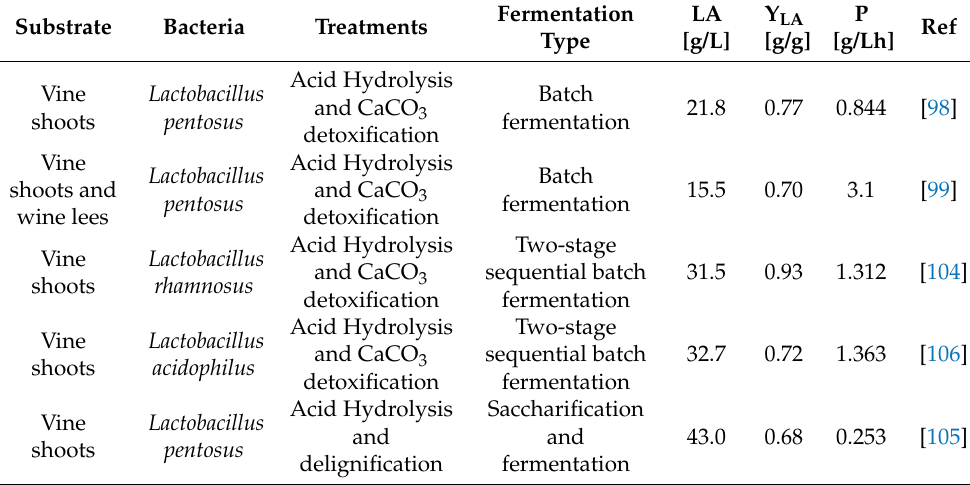
Table 4. Microbial synthesis of lactic acid using different wine by-products as fermentative